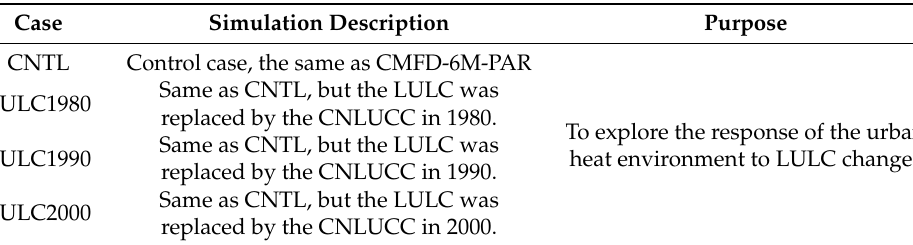
Table 3. The experiment design for the response of SUHI to LULC.